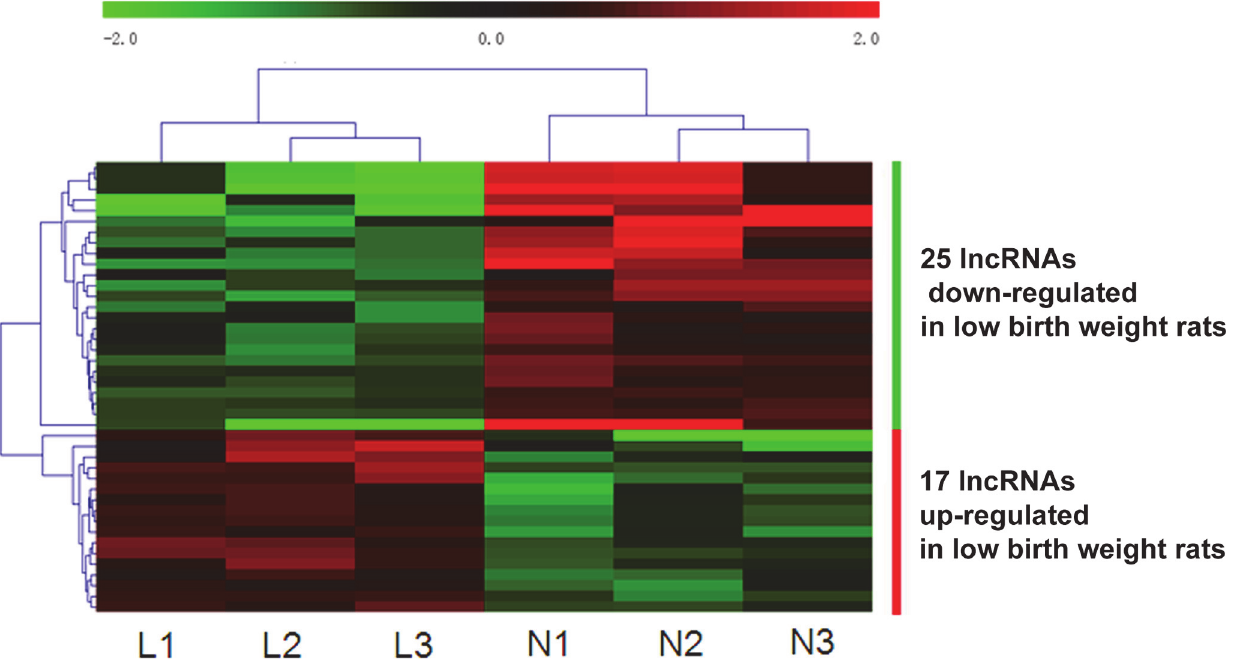
Fig 2. Hierarchical clustering of lncRNAs differentially expressed in kidney between low birth weight and control rates. A hierarchical clustered heat map showing the log 2 transformed expression values for differentially expressed lncRNAs (absolute fold-change (cid:1) 2; p (cid:4) 0.05) between low birth weight rats (L) and normal controls (C). Three rats were analyzed for each group. The intensity of the color scheme is calibrated to the log 2 expression values, where red refers to high relative expression and green refers to low relative expression. The bar code represents the color scale of the log 2